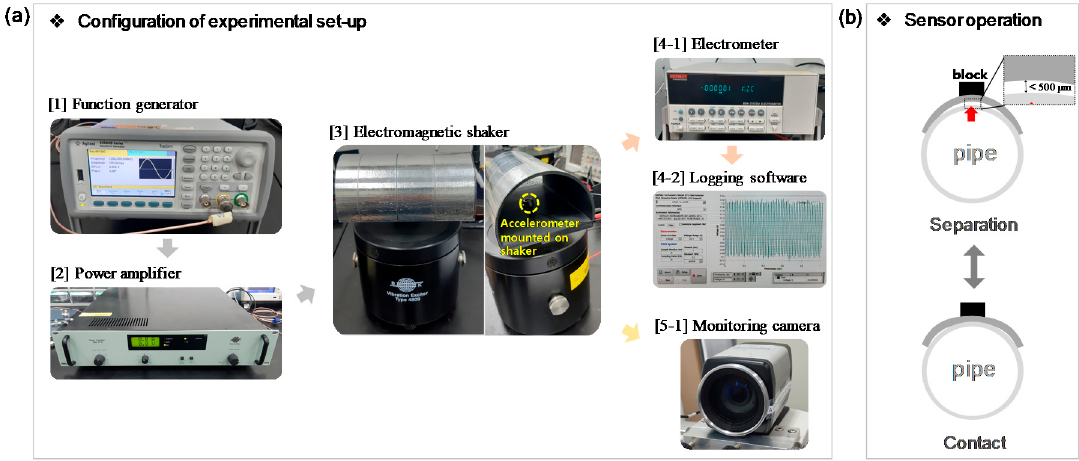
Figure 2. ( a ) Configuration of experimental setup. ( b ) Schematic illustration of the PVV sensor operation.